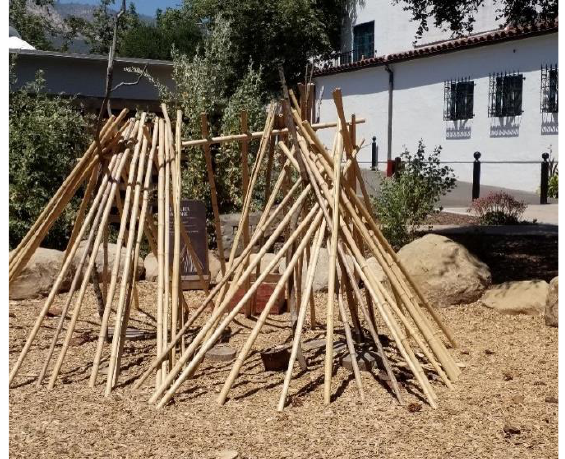
Figure 5. Lower creek area.